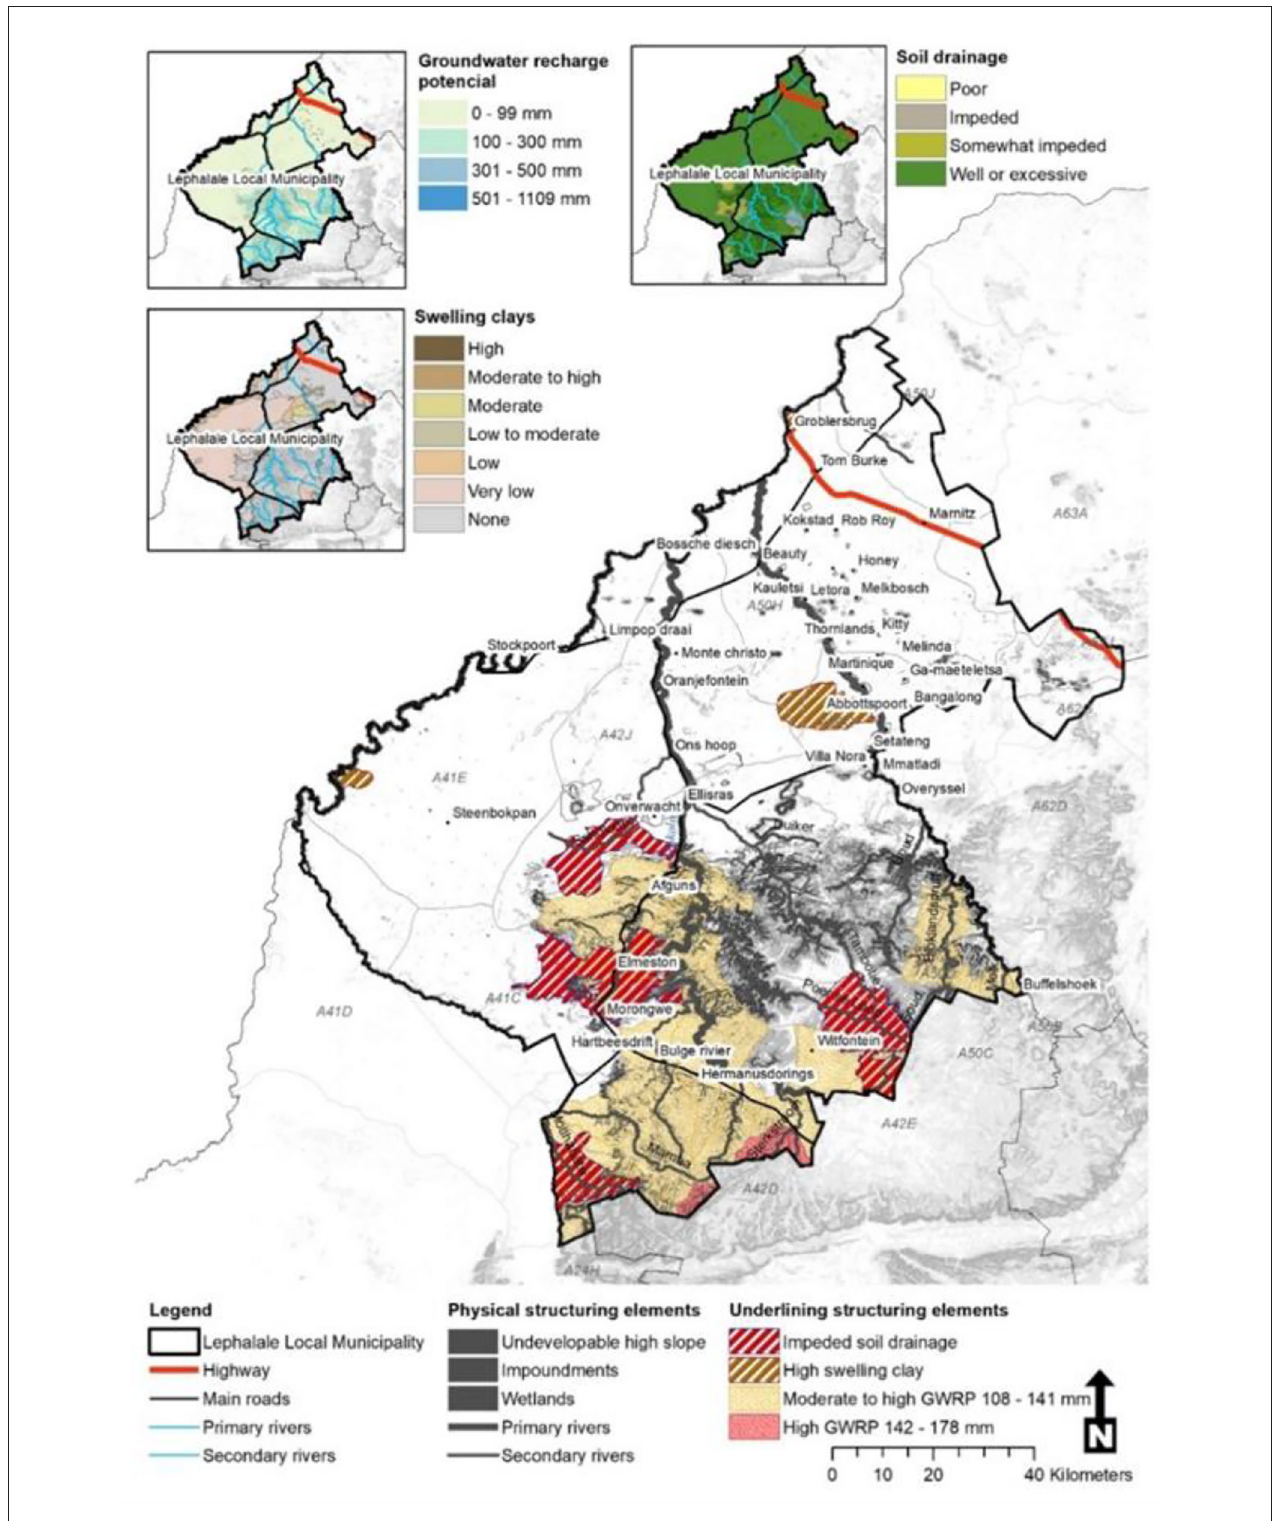
FIGURE 2 | Lephalale’s physical and underlining structuring elements. Source: Rohr, 2019, p. 170.